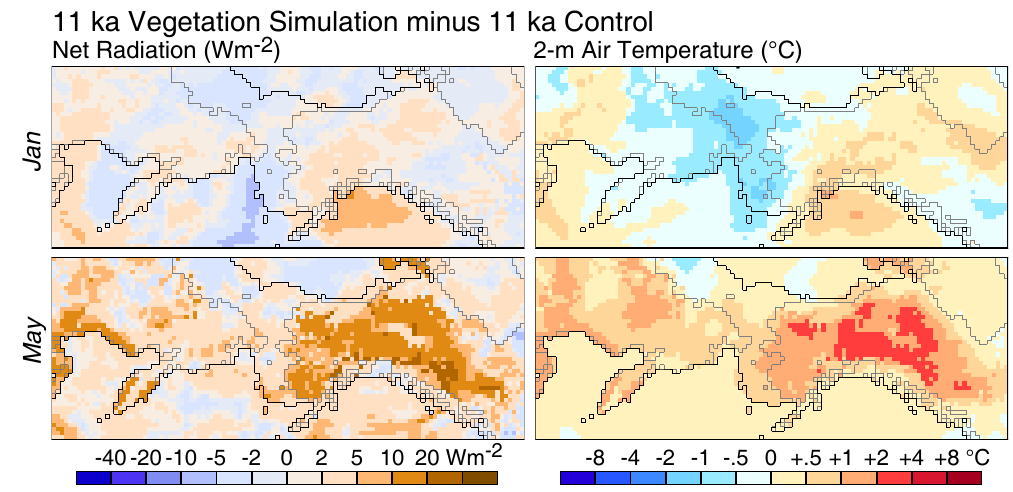
Figure 7. Results of 11ka Vegetation experiment ( 11ka Vegetation minus 11ka Control ). Panels show net radiation (left) and 2m air temperature (right) for January (upper) and May (lower). The effect of taller, denser shrub/tree cover is seen most strongly in May, when 2m air temperatures increase by 1–3 ◦ C over the control values. Ice-sheet and coastal outlines as in Fig. 4.